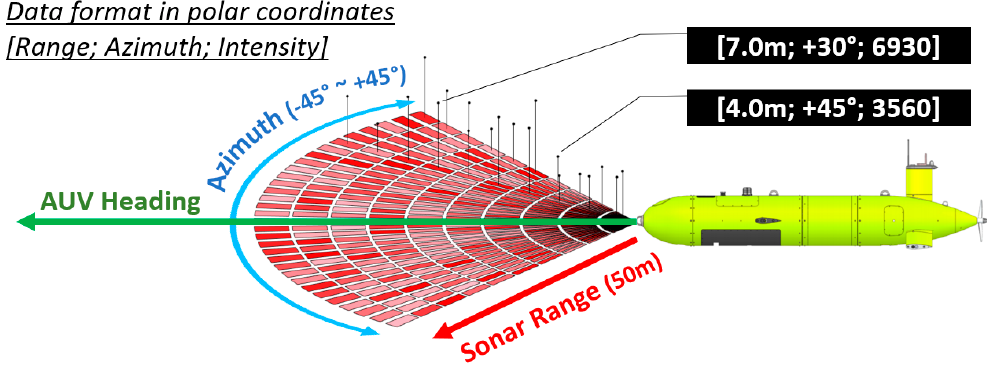
Figure 5. A descriptive sensor model of the sonar signal detection. The measurements include the acoustic intensity values for each tessellated polar grid cell.